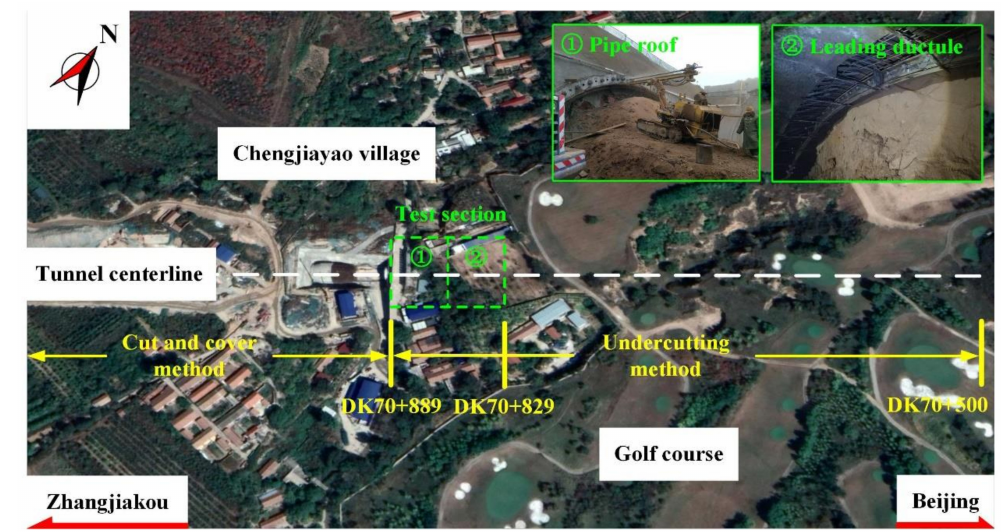
Figure 1. Map of Beijing-Zhangjiakou high-speed railway.